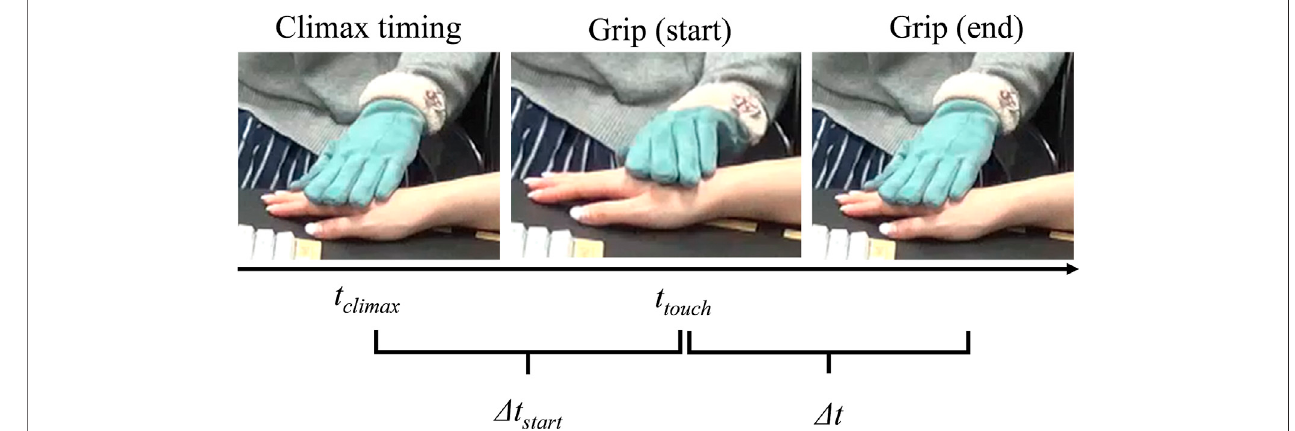
FIGURE 2 | Illustration of t climax , t touch , Δ t, and Δ t start .